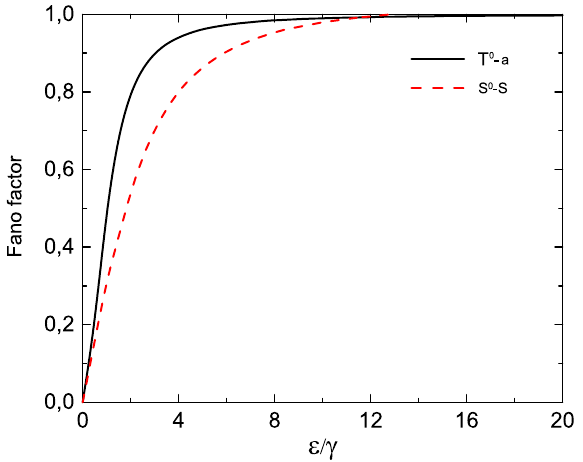
Figure 14. Fano factor as a functions of energy for the symmetric tunneling contact in the limiting case 1 for the T 0 a channel—black solid curve and for the S 0 eV /γ − ≪ Temperature is equal to 0.01 ε .